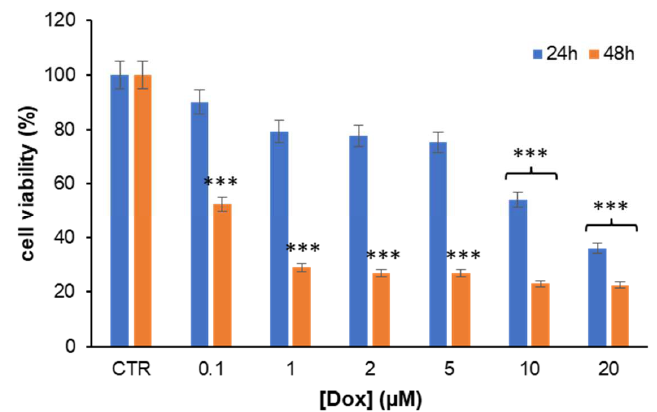
Figure 2. Evaluation of Dox cytotoxicity in cardiomyoblasts. Cell viability was evaluated by MTT assay in H9c2 cells exposed for 24 and 48 h to an increasing concentration of Dox (from 0.1 to 20 µ M). CTR: untreated cells. Data are expressed as average percentage of MTT reduction ± SD relative to untreated cells from triplicate wells from 5 separate experiments. Other experimental details are described in the Materials and Methods section. *** p ˂ 0.001 versus CTR.